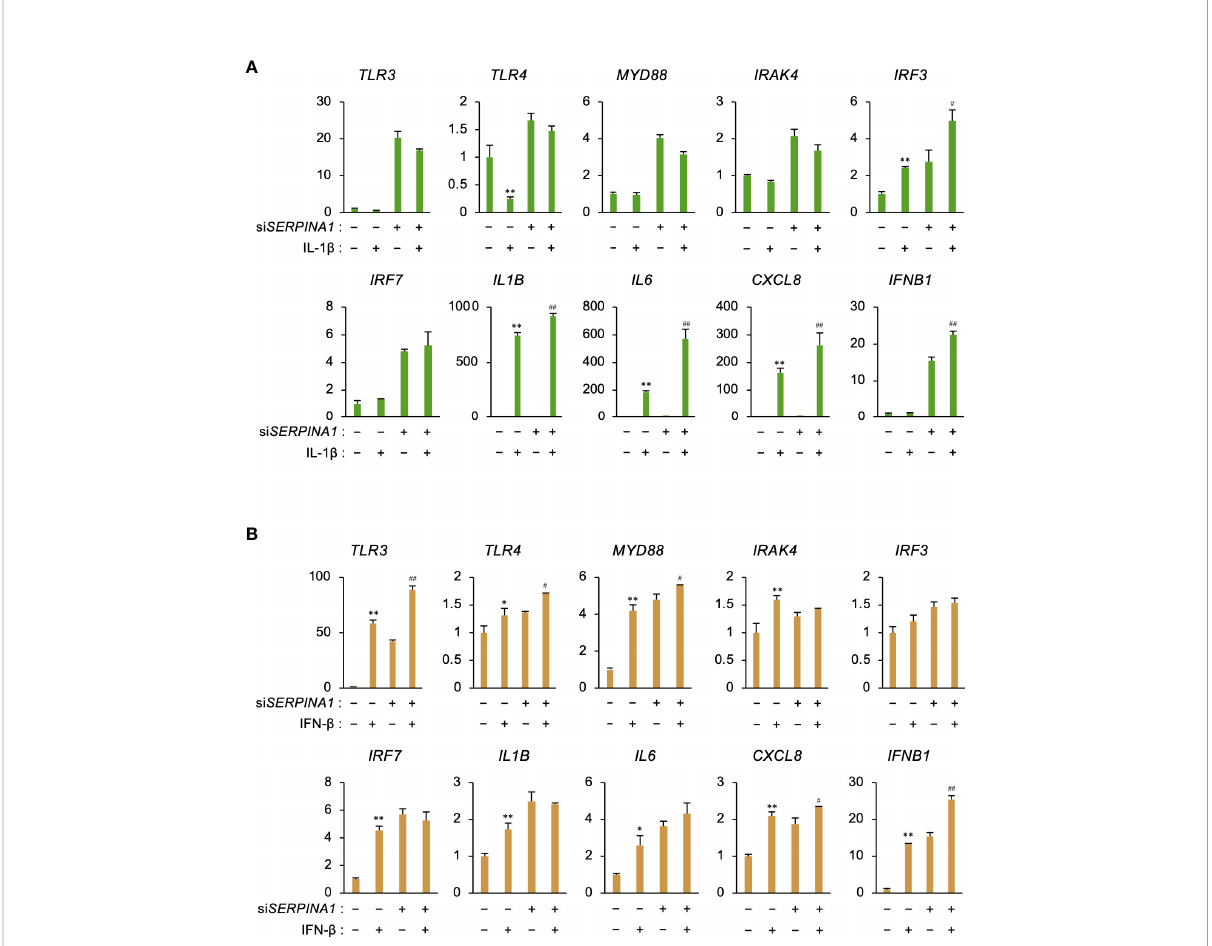
FIGURE 4 IL-1 b or IFN- b increases expression of in fl ammatory-related genes. (A, B) Expression of TLR3 , TLR4, MYD88, IRAK4, IRF3, IRF7, IL1B, IL6 , CXCL8, and IFNB1 in primary ESCs transfected for 24 h with si SERPINA1 and then treated with IL-1 b ( A ; 10 ng/ml) or IFN- b ( B ; 500 ng/ml) (n=3). GAPDH was used as the reference gene. Values represent the mean ± SEM of three independent experiments. * P <0.05, ** P <0.01 vs. Ctrl. # P <0.05, ## P <0.01 vs. si SERPINA1